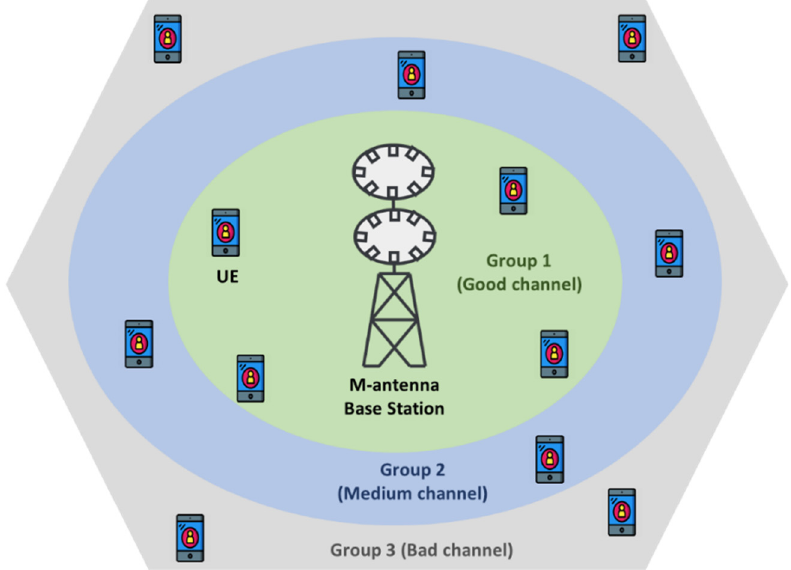
Figure 1. A wireless system environment containing M -antenna BTS serving N s UEs out of N a UEs.